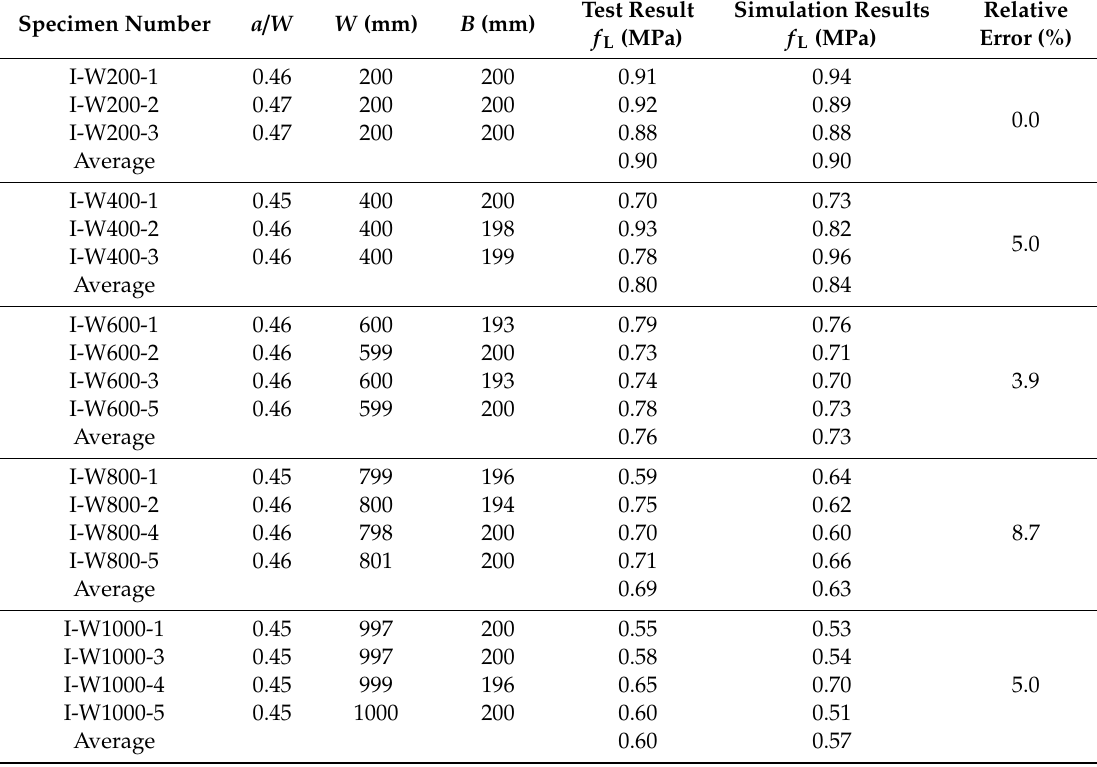
Figure 6. P -CMOD (Crack Mouth Opening Displacement) curves of WS and 3-p-b specimens [43]. Table 3. Simulation results for WS specimens.